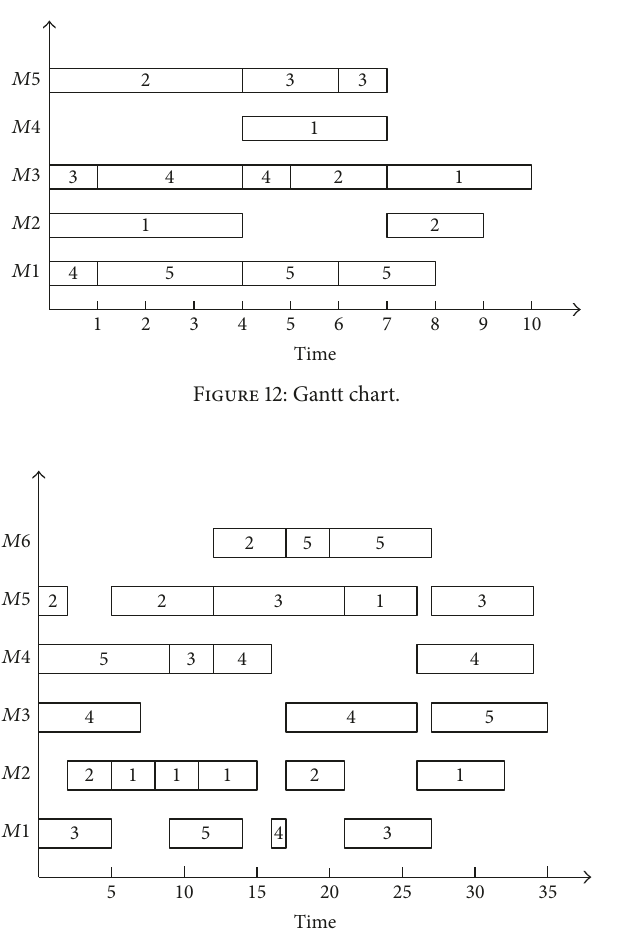
Figure 13: Static scheduling Gantt chart.